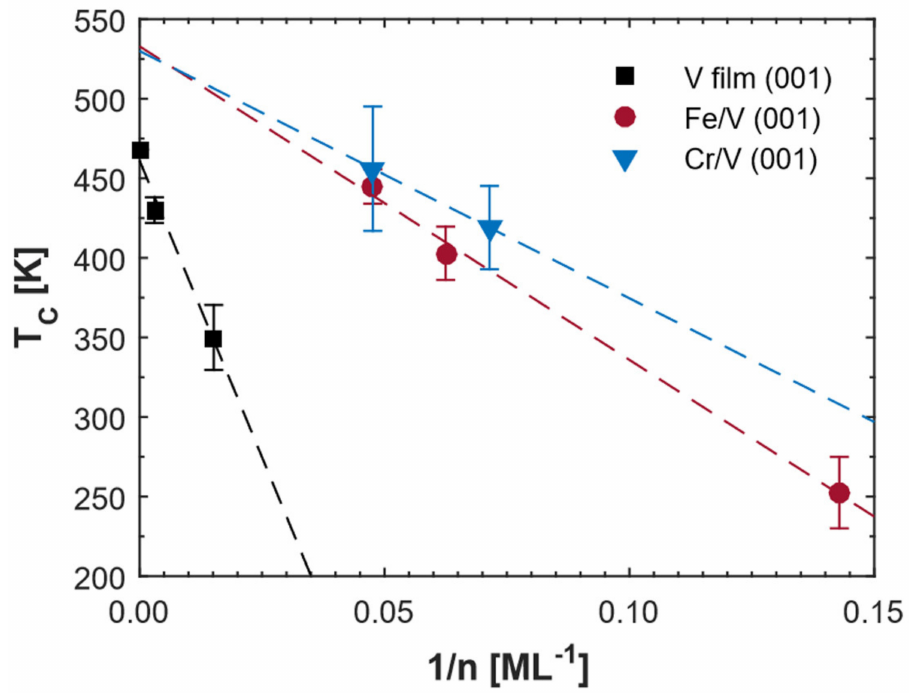
Figure 5. Critical temperatures of hydrogen in Cr/V (001) superlattices as a function of inverse V monolayer number. Fe/V (001) superlattices and V films are shown for comparation [5].